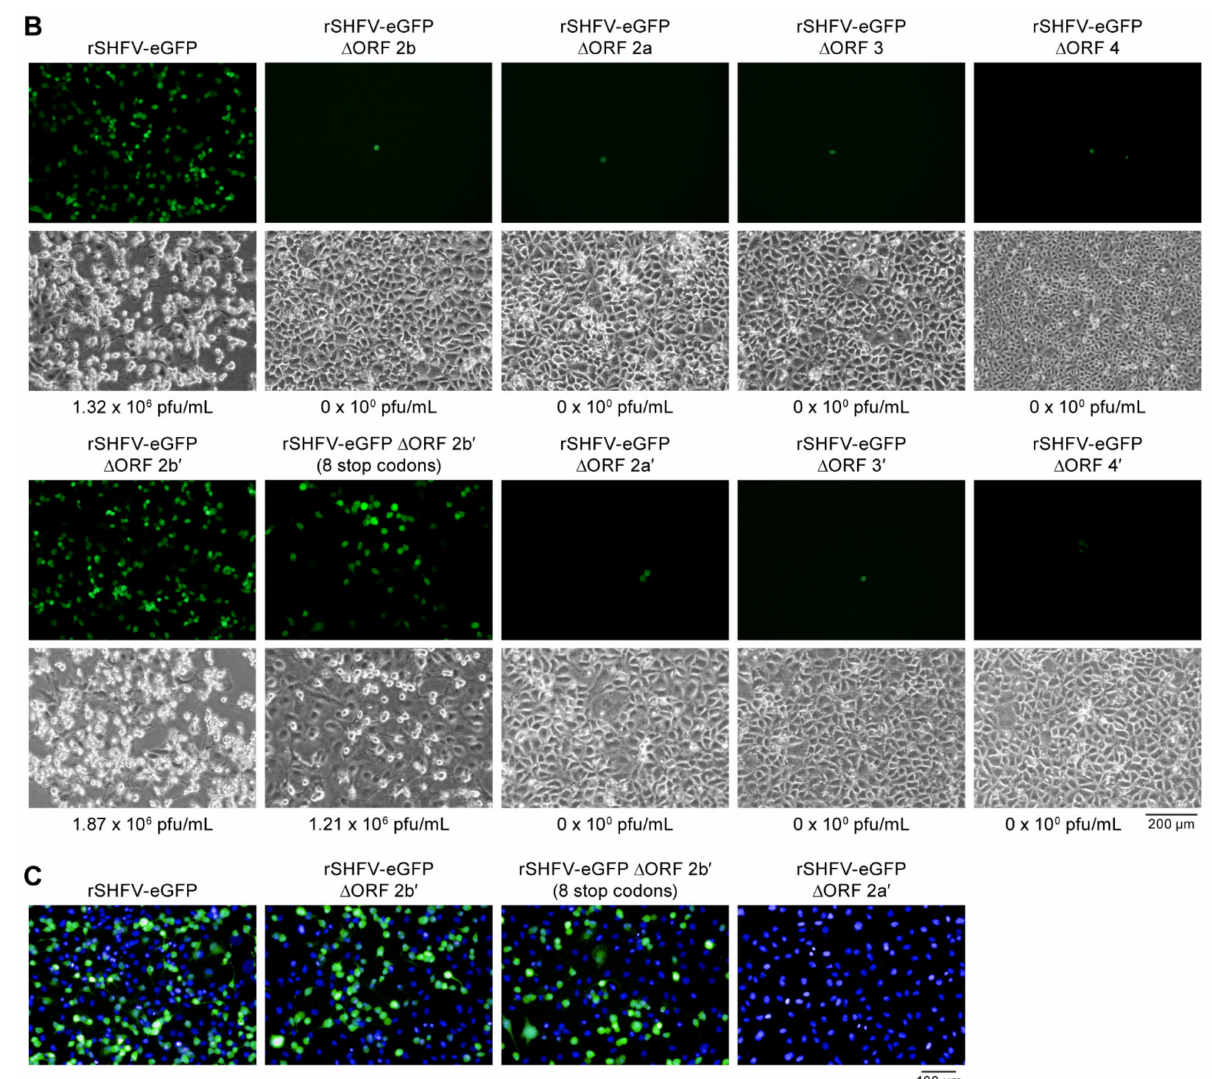
Figure 7. Minor structural protein E’ is dispensable for infectious simian hemorrhagic fever virus (SHFV) particle production in vitro. ( A ) To analyze the functional importance of SHFV minor structural proteins, stop codons (red) were introduced into the respective open reading frames (ORFs) of pCMV-SHFV-eGFP without altering the amino acids encoded in overlapping ORFs. ( B ) MA-104 cells were transfected with the pCMV-SHFV-eGFP mutants. Supernatants were harvested at 48 h p.t. and subjected to plaque assay. Top row: epifluorescent microscopic images of eGFP-generated fluorescence. Bottom row: Compound microscopic images of cells with plaque-assay titers printed beneath them. ( C ) MA-104 cells were exposed to supernatants harvested in ( B ) and eGFP expression was measured by epifluorescence